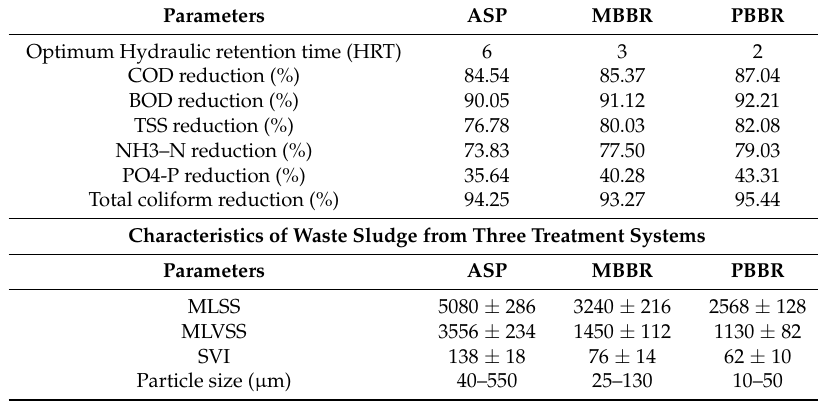
Table 1. A comparative analysis of the performance and the characteristics of the sludge from the three biological treatment processes